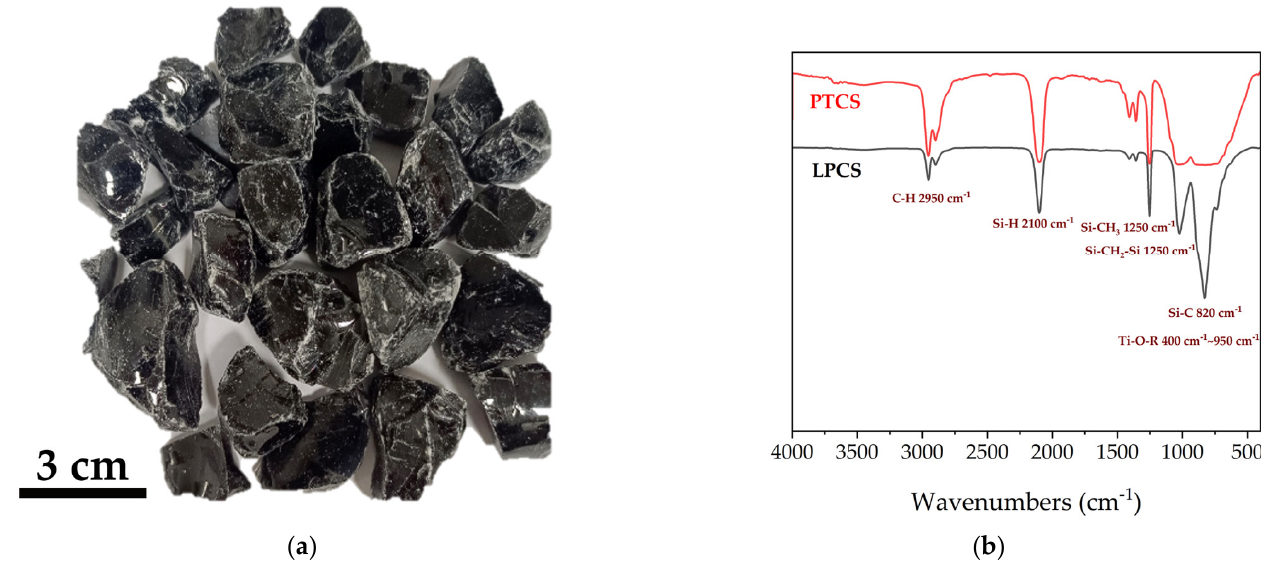
Figure 1. ( a ) Optical photo of the PTCS precursor. ( b ) Infrared spectrum of LPCS and PTCS. The 1 H NMR spectrum of precursors in Figure 2a shows the peaks with chemical shifts around − 0.30 ppm, 0 ppm, 0.18 ppm, 0.92 ppm, 1.36 ppm and 4.65 ppm, which prove the presence of CH 2 , Si(CH 3 ) 4 , Si–CH 3 , O–alkyl, –OH and Si–H groups in the PTCS precursor. In addition, the peaks around 4.65 ppm also confirm the presence of remaining From 29 SiNMR spectrum of precursors in Figure 2b, it can be seen that there are two peaks located around − 16 and 0 ppm, which could be attributed to SiC 3 H and SiC 4 bonds, could be calculated by comparing the corresponding areas of the two peaks, which are about 1.64 and 1.39,